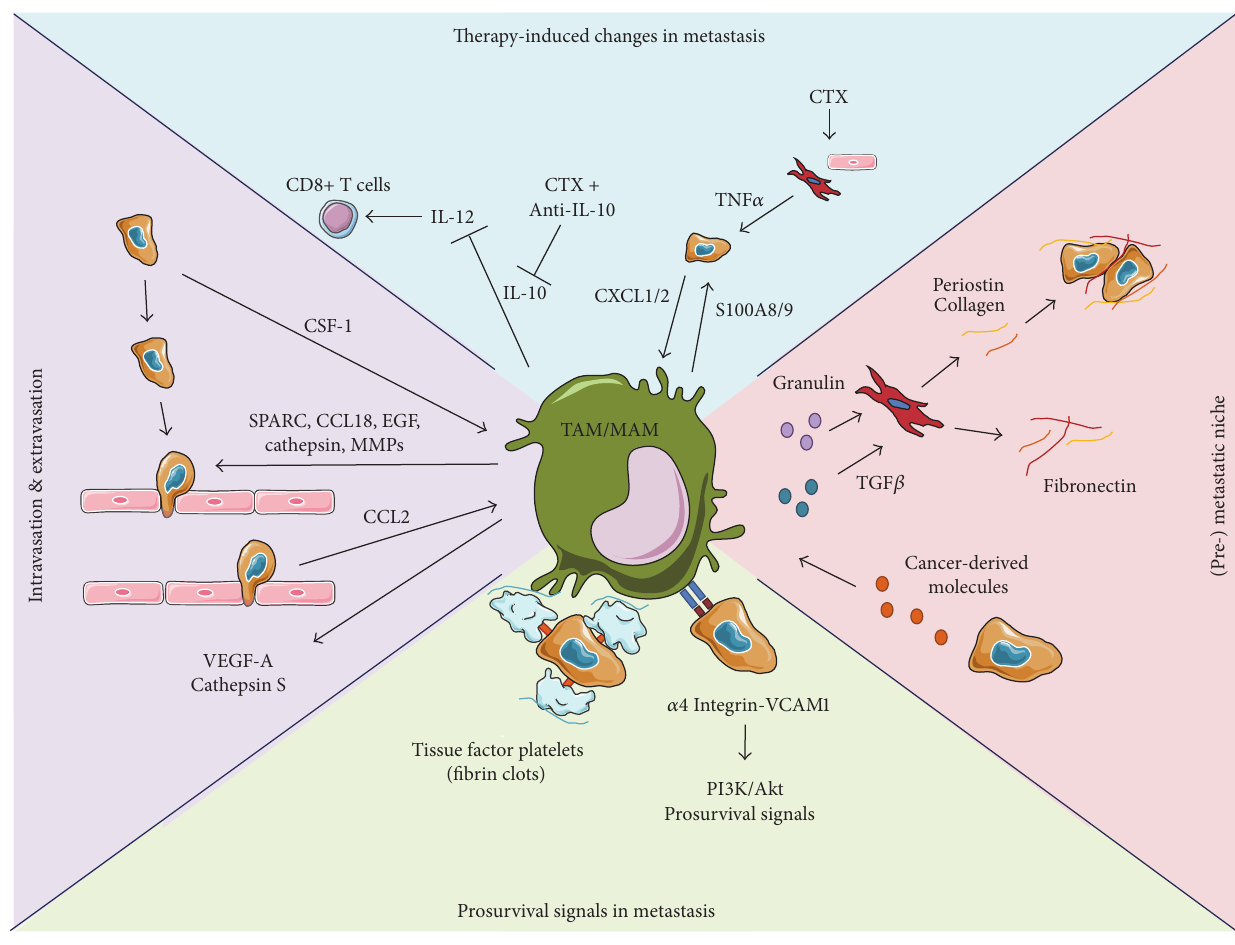
Figure 1: Prometastatic functions of macrophages. Macrophages promote invasion and intravasation of tumour cells at the primary site ( purple ). Tumour cells produce CSF1 that induces EGF expression in TAMs. This autocrine loop leads to comigration of tumour cells and macrophages towards blood vessels where macrophages produce VEGF-A to promote increased vessel permeability. In addition macrophage- derivedmoleculessuchasSPARC,CCL18,andproteasespromoteincreasedtumourcellinvasionandmigration.Atthemetastaticsite,tumour cell-derived CCL2 recruits inflammatory monocytes to the metastatic site, where they differentiate into metastasis-associated macrophages that produce VEGF-A and cathepsin S to promote cancer cell extravasation. Macrophages promote survival at the metastatic site ( green ). Macrophages express integrin 𝛼 4 that engages VCAM1 on tumour cells at the metastatic site, which increases tumour cell survival through PI3K/Akt signalling. In addition, macrophages bind to fibrin complexes on tumour cell-associated platelets, which increase tumour cell survival in the initial phase of metastatic colonisation. Macrophages promote metastatic niche formation ( pink ). Metastasis-associated macrophages produce granulin that activates HSTC to produce ECM molecules, such as collagen and periostin, which enhances the colony formation abilities of cancer cells in the metastatic niche of pancreatic cancer. In addition, tumour-derived exosomes can activate TGF 𝛽 expression in Kupffer cells that activates HSTCs to produce fibronectin in the premetastatic liver. Macrophages promote therapeutic resistance ( blue ). Macrophages produce IL-10 that inhibits the effector functions of CD8+ T cells by blocking the effects of dendritic cell-derived IL-12. Inhibition of IL-10 with a blocking antibody in combination with chemotherapy improves the therapeutic response. Tumour cells express CXCL1/2 that induces S100A8/9 production in macrophages to improve tumour cell survival. Chemotherapy induces TNF 𝛼 expression from cancer-associated fibroblasts and endothelial cells that reinforces the CXCL1/2-S100A8/9 axis and limits the efficacy of